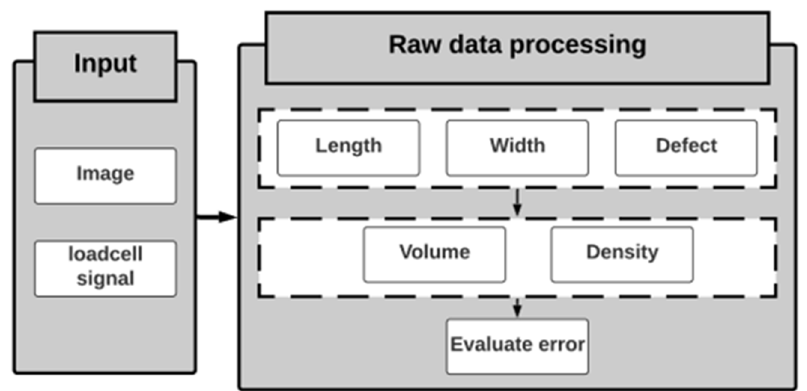
Figure 8. The estimation process of volume and density.